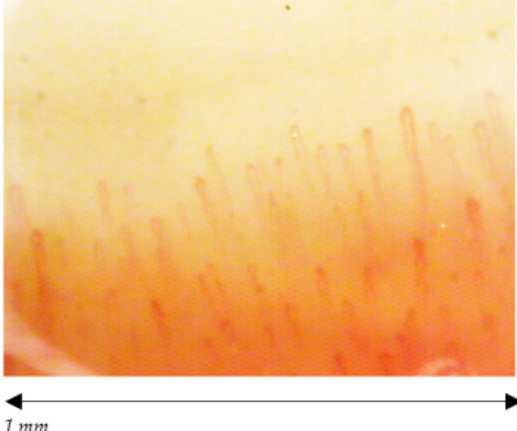
Figure 2. Male normal pattern; density ≥ 7, normal dimension of capillaries, no abnormal morphology, no hemorrhages.